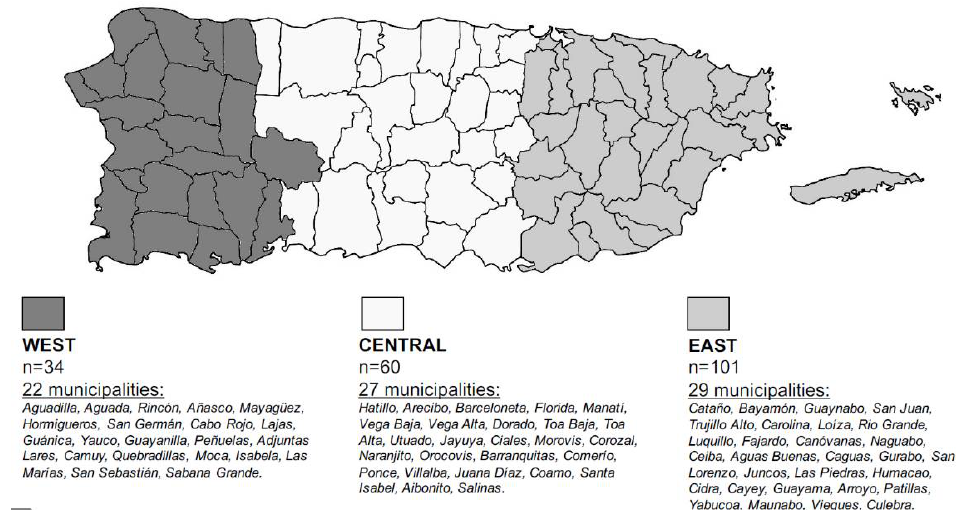
Figure 1. Ethno-geographic distribution of the total samples collected for the study. Sampling strategy was population-based and stratified-by-region, according to the 2004 National Registry of Births in the Commonwealth of Puerto Rico. n Indicates the number of samples collected per region. In parentheses, the number of municipalities from each region of the Island of Puerto Rico where at least one of the collected samples came from is indicated (i.e., 77 out of 78 municipalities are represented).